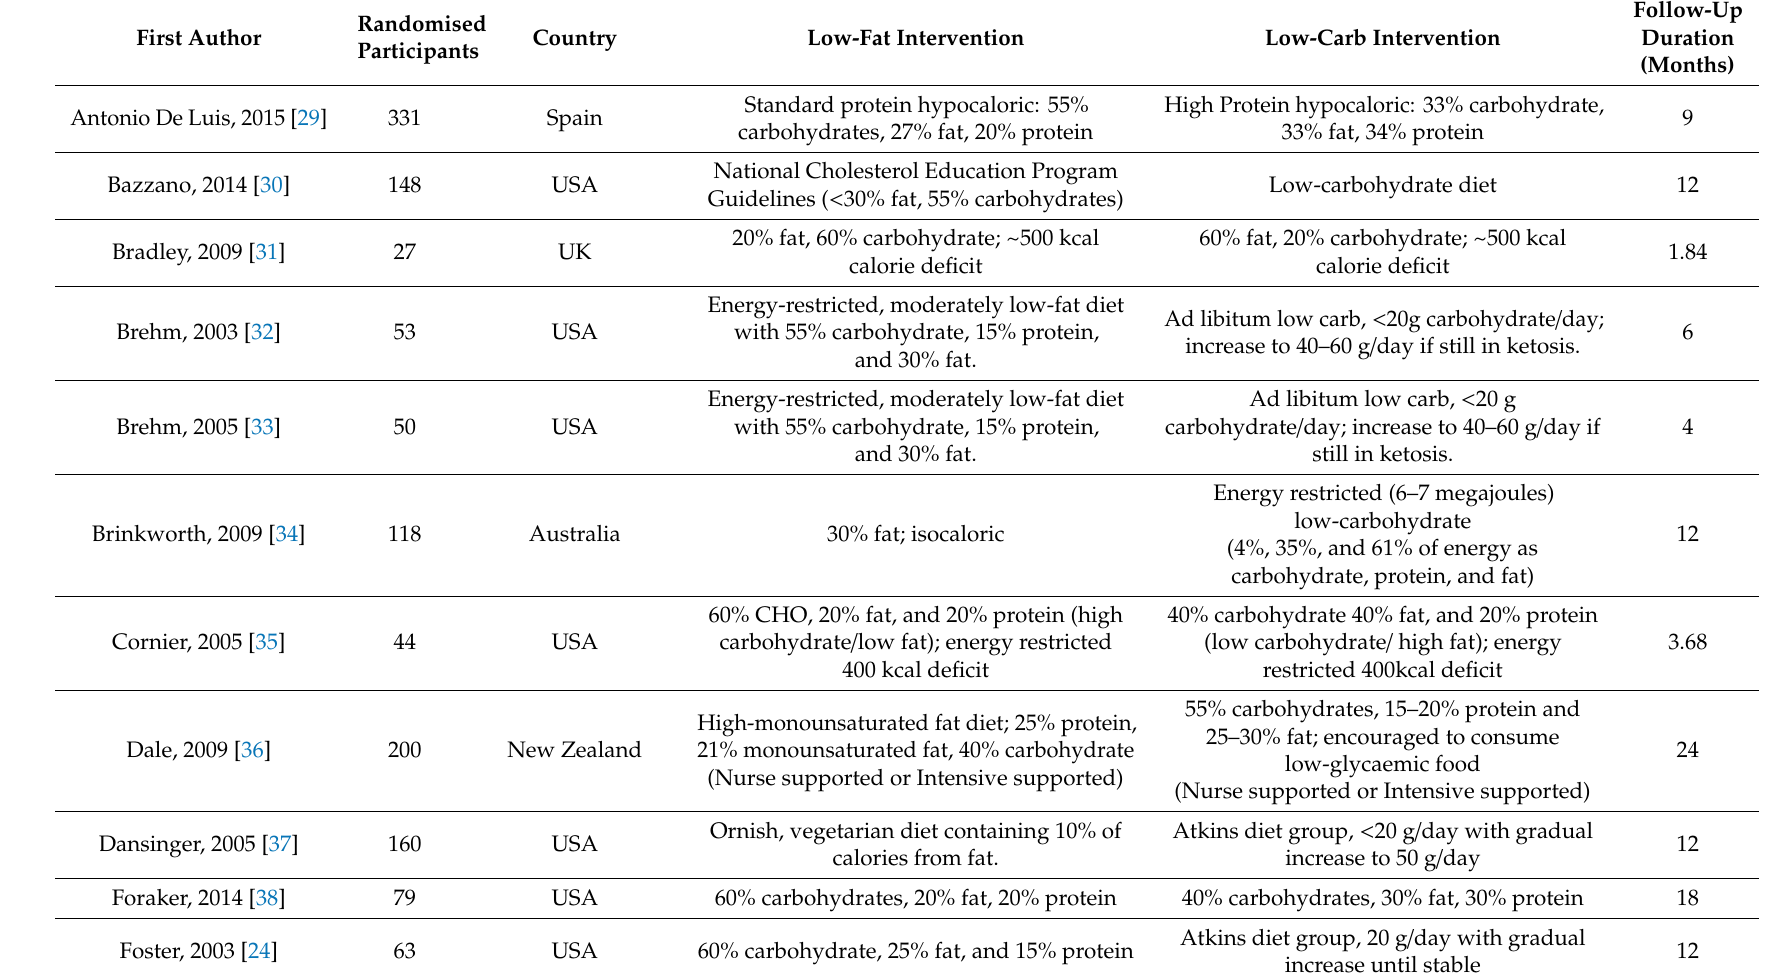
Table 1. Study characteristics of randomised trials of low-fat vs. low-carbohydrate dietary